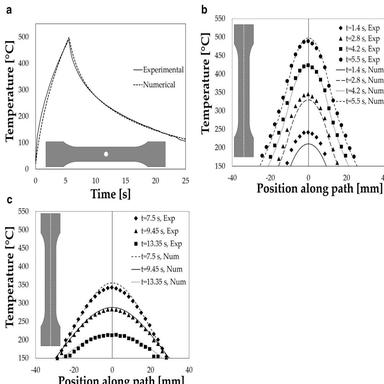
Results from the inverse analysis (experimental data were obtained from the test conducted setting the laser power to 500 W and the dwell time to 5.5 s): a temperature evolution of the point located at the center of the irradiated surface; temperature distribution during the b heating and c cooling down to room temperature.